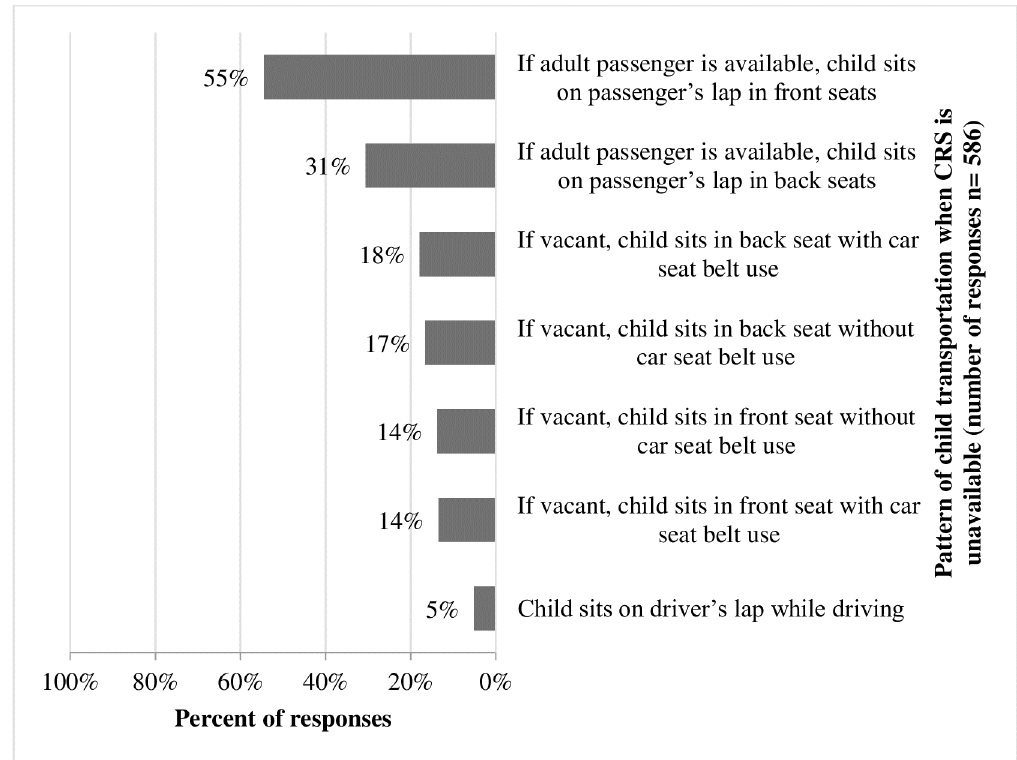
Fig 1. Pattern of child transportation when CRS is